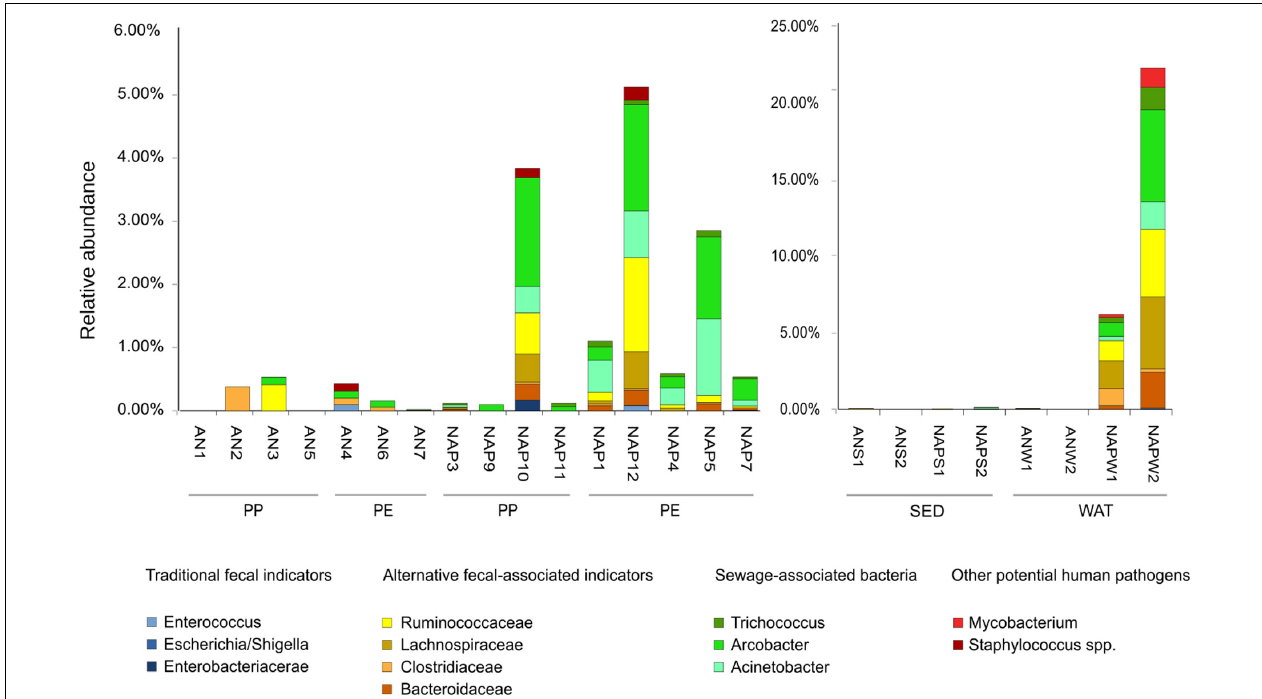
FIGURE 6 | Bar plots of relative abundance (based on the number of reads of 16S rDNA sequences) of sequences belonging to the traditional, and alternative (feces-associated and sewage-associated) fecal indicator bacteria, in the plastic (left panel) and seawater and sediment samples (right panel). Y -axis shows the relative abundance (please, note the difference in scale between the two panels). Taxa listed in the “Materials and Methods” section as indicator bacteria or other potential pathogens not detected in our dataset are not listed in the figure legend.